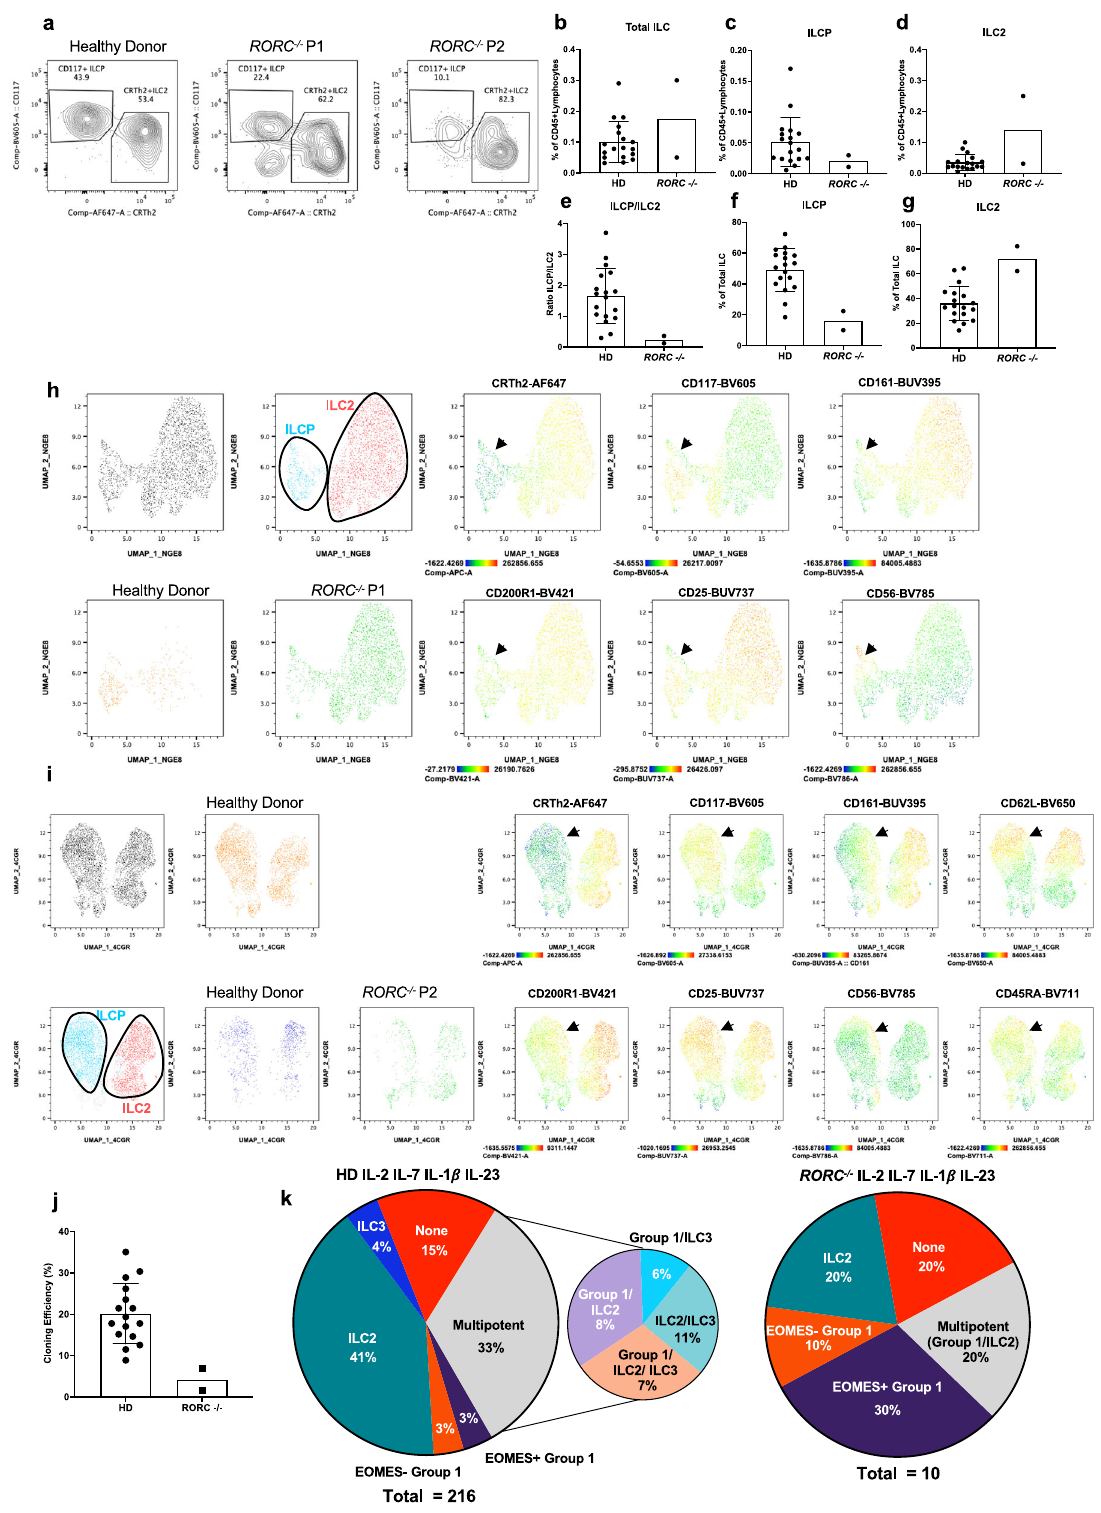
Fig. 2 | Human ILCdifferentiation in RORC − / − patients.a Flow cytometricanalysis of ILCs from a healthy donor and two RORC − / − patients (gating strategy in Supple- mentaryFig.1).Relativefrequenciesof b totalILC( c )ILCP( d )andILC2inCD45+live lymphocytes. e Ratio of ILCP to ILC2. Relative frequencies of f ILCP and g ILC2 in totalILCs. h – i Uniformmanifoldprojection(UMAP)analysesonhealthydonorsand RORC − / − patients. h UMAPofexperimentwithP1andhealthydonorand( i )UMAPof